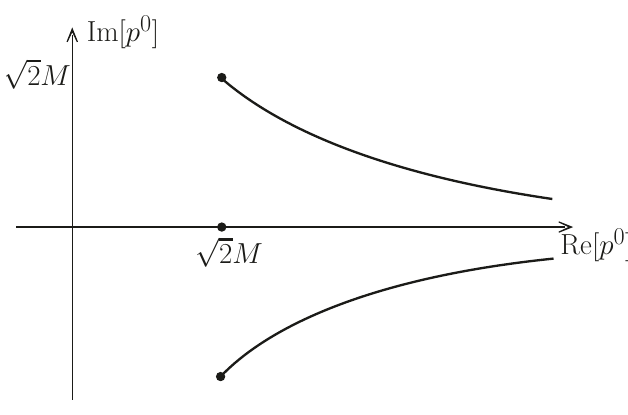
Figure 8 . Branch cuts due to the Lee-Wick pinching at p =